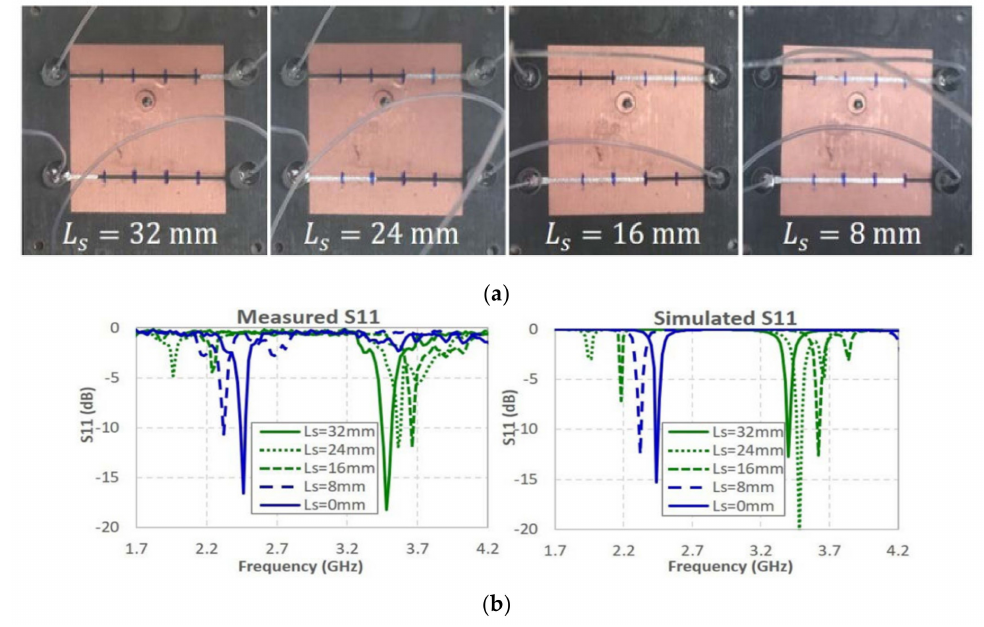
Figure 12. ( a ) Photograph of single-pair slot PASS with different Ls states. ( b ) Measured and simulated S 11 for varied Ls. Reprinted with permission from Ref. [55]. Copyright IEEE